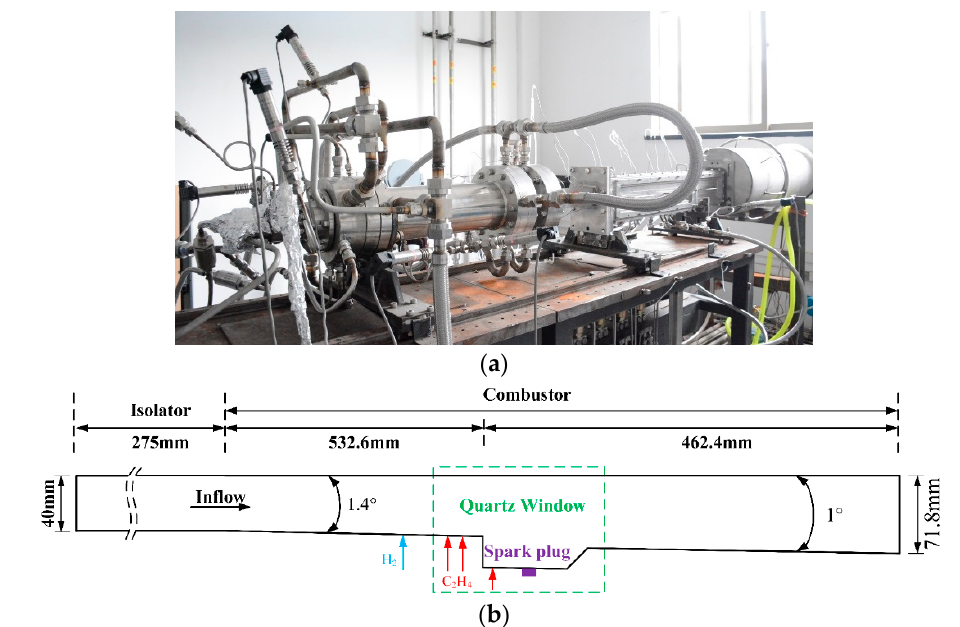
Figure 1. Direct-connected experimental facility ( a ) and schematic of the model scramjet engine ( b ). Table 1. Inflow conditions of the scramjet combustor.